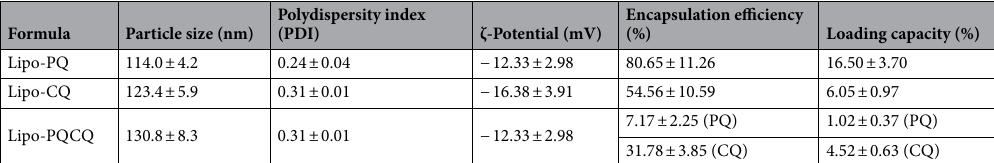
Table 1. Characteristics of liposomes loaded with primaquine/PQ (Lipo-PQ), chloroquine/CQ (Lipo-CQ), and both drugs (Lipo-PQCQ) following incubation at 60 °C for 20 min. Each value represents the mean ± SD (n =